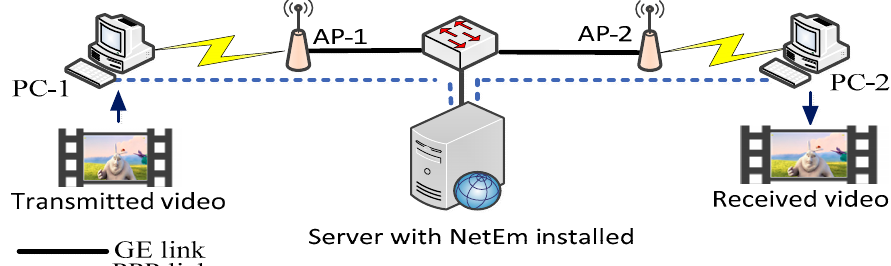
Figure 2. Network setup used in the study.